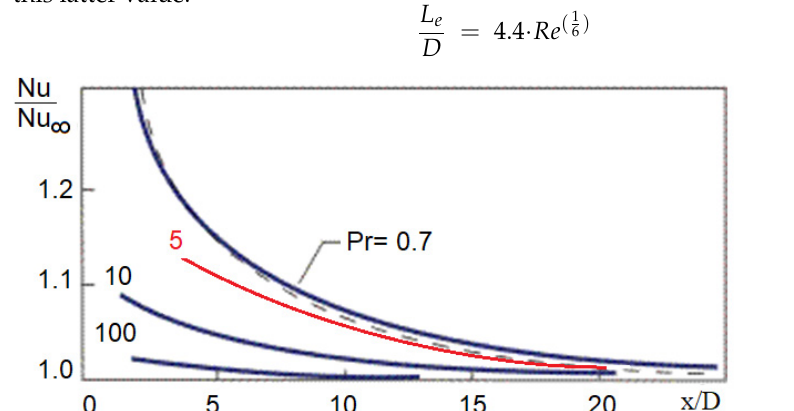
Figure 7. Effect of the Pr number on the development of HT in a tube. Table 6. The entry length variation D = 0.016 m.